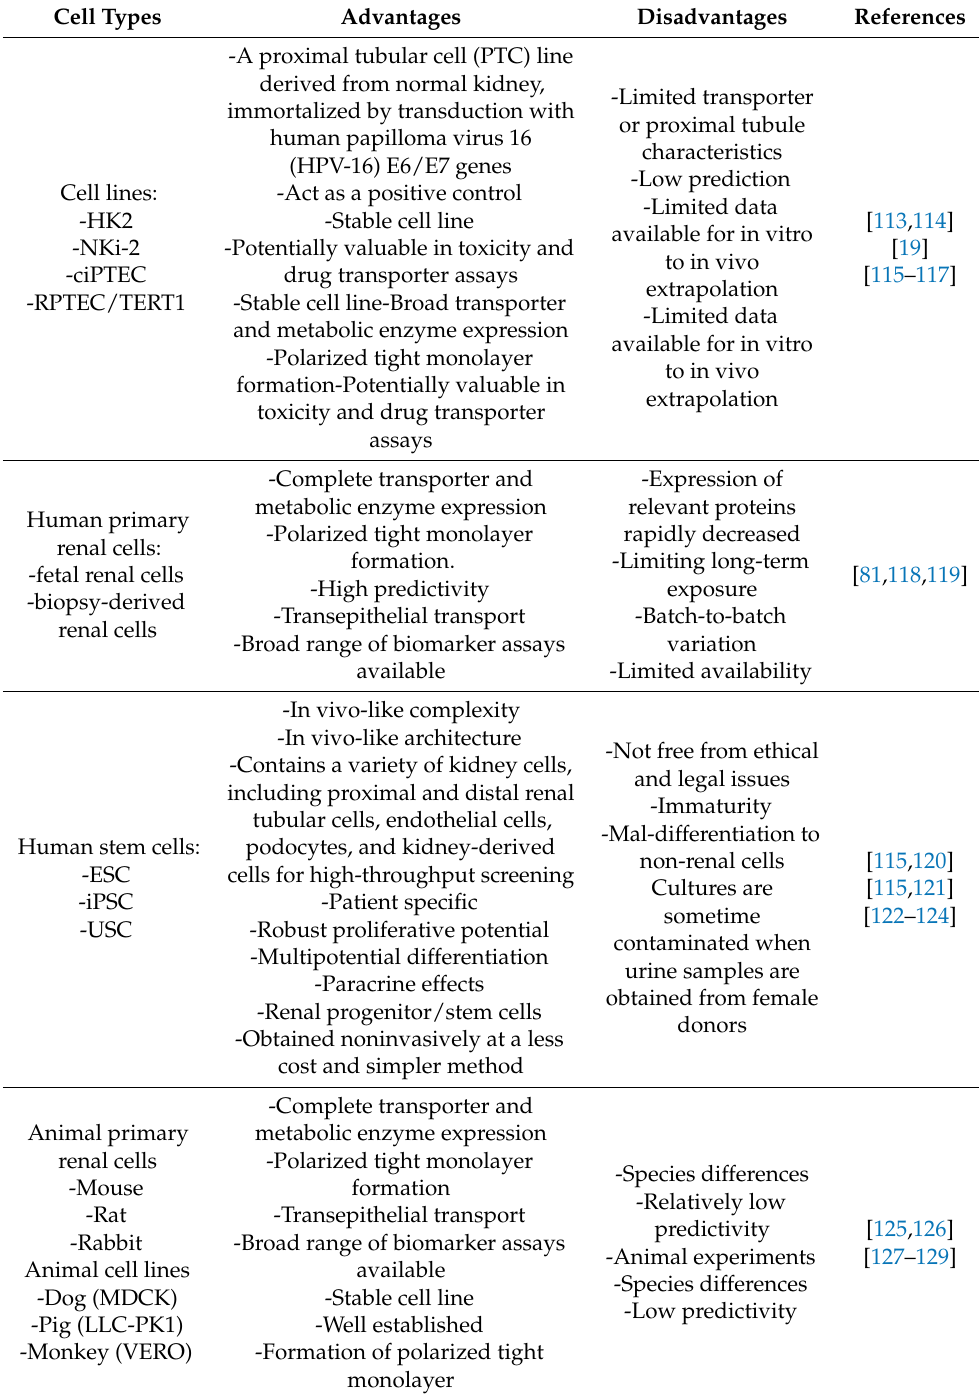
Table 4. Different cell types used in 3D culture